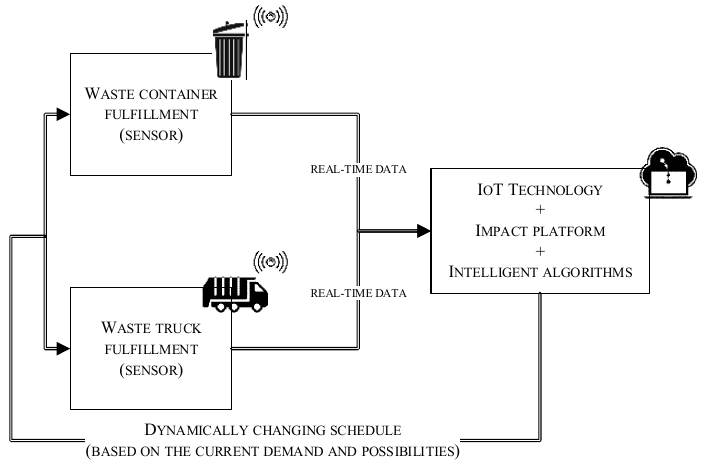
Figure 5. New emptying system diagram.